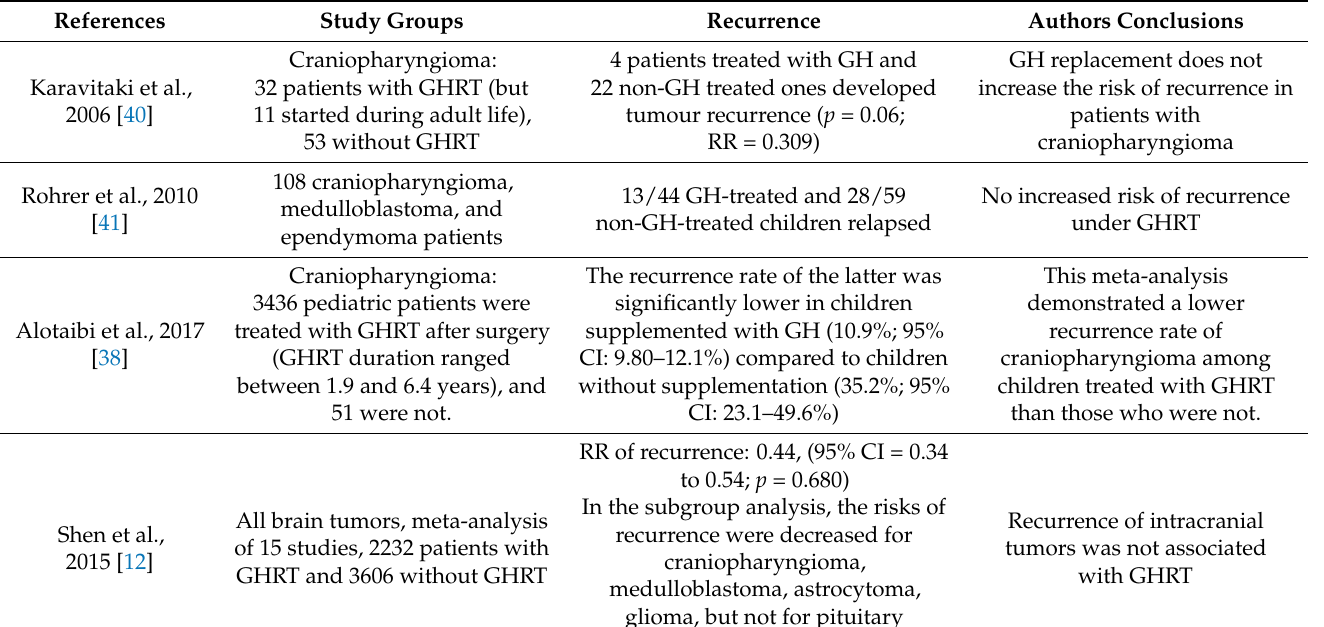
Table 5. Main articles in the literature concerning growth hormone supplementation in children with brain